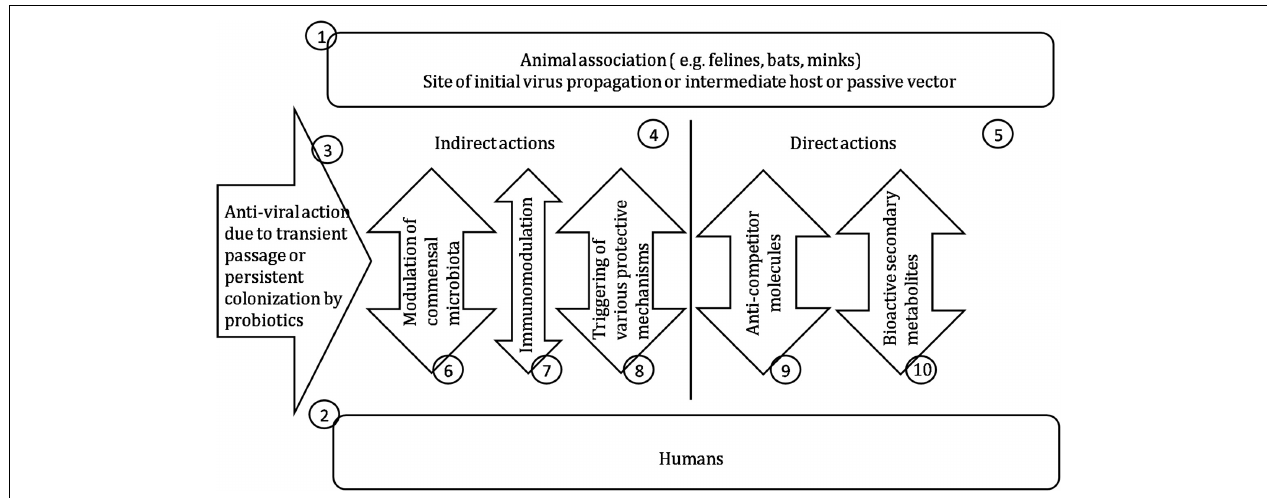
FIGURE 2 | Probiotics for control of viral infections. (1) Either the original virus source or a vector functioning as alternative replication host or for mechanical transfer of the virus. (2) The newly acquired host for virus proliferation. (3) Probiotic intervention may be either short –term or enduring depending on the colonization efficacy of the probiotic. (4) Boosting of the host’s own tissue, immunological or microbiota defenses following interaction with the probiotic. (5) Direct antiviral activity of probiotic cellular components or extracellular products. (6) Temporary or persisting microbiota changes following probiotic exposure associated with enhanced antiviral activity. (7) Boosting the innate antiviral immune defenses. (8) Up-regulating antiviral defenses of non-immunological body components. (9) Probiotic products having anti-competitor roles such as bacteriocins and ribosomally synthesized, posttranslationally modified peptides (RiPPs). (10) Probiotic metabolites detrimental to virus